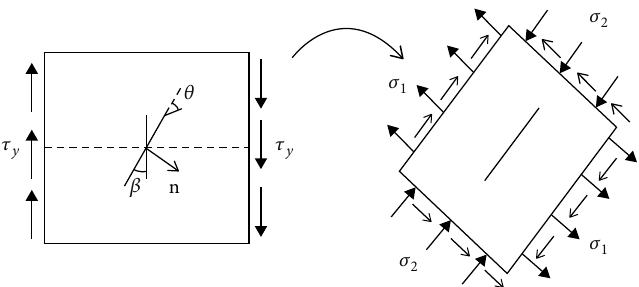
Figure 8: Schematic diagram of fracture tip expansion in level direction of rock beam.